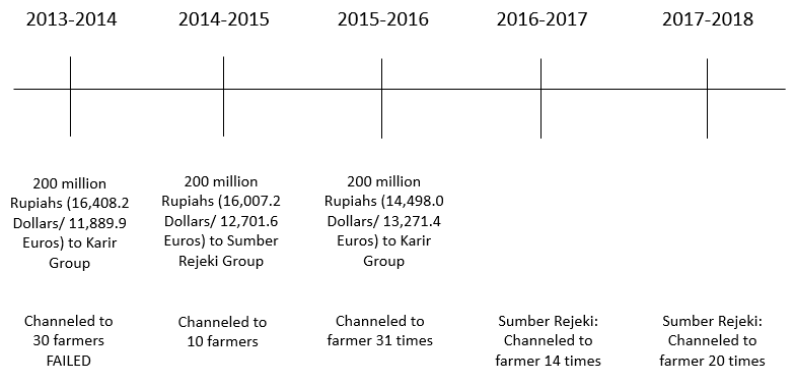
Figure 2. KMP program implementation timeline.